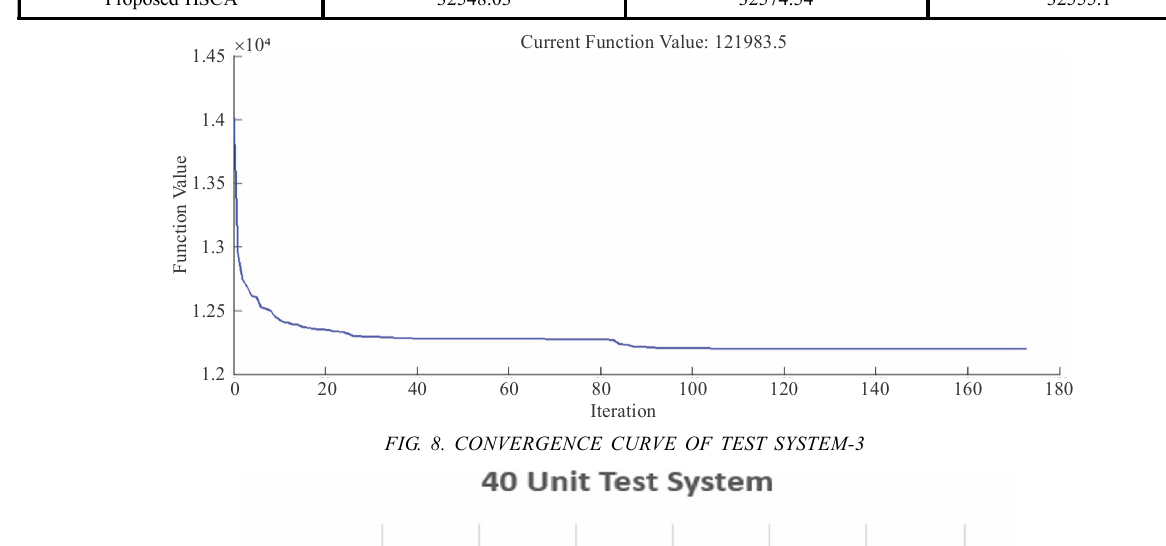
FIG. 8. CONVERGENCE CURVE OF TEST SYSTEM-3